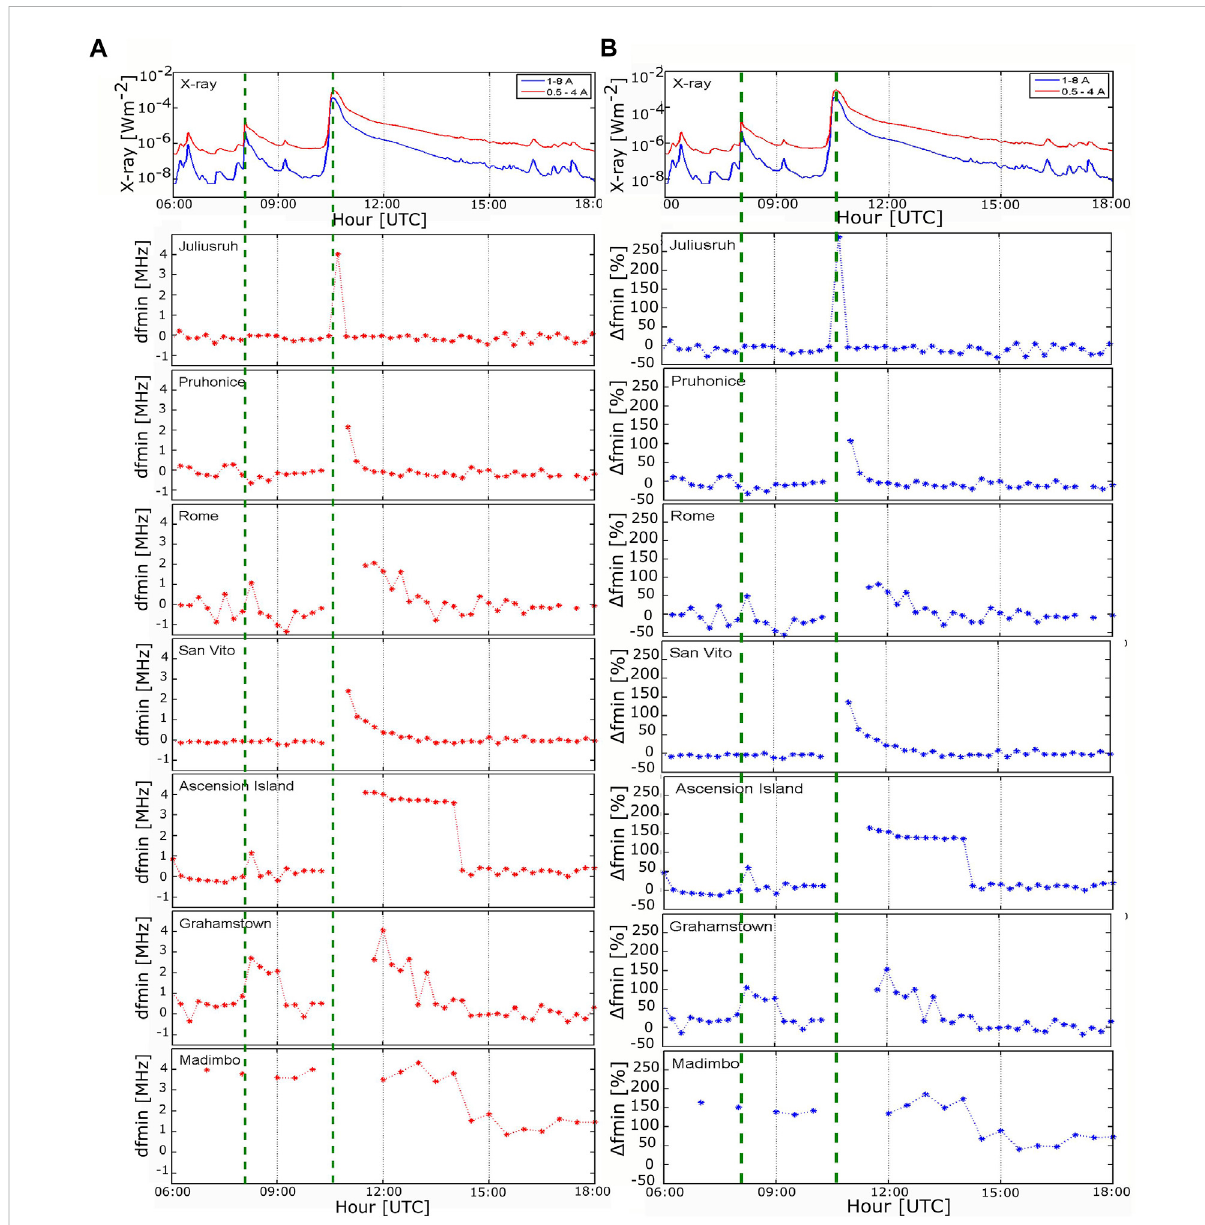
FIGURE 5 ThevariationofX-ray fl ux(upperplots)andthedfmin (A) and Δ fminparameters (B) detectedatdifferentstations(fromhighertolowerlatitudes) between 06:00 and 18:00 on 05 December. The green dashed lines indicate the time of the investigated fl